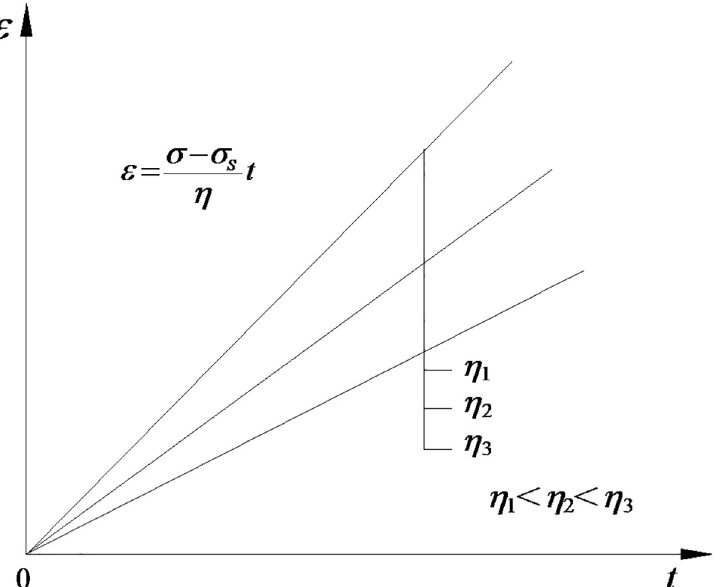
Fig 5. N|Y strain time